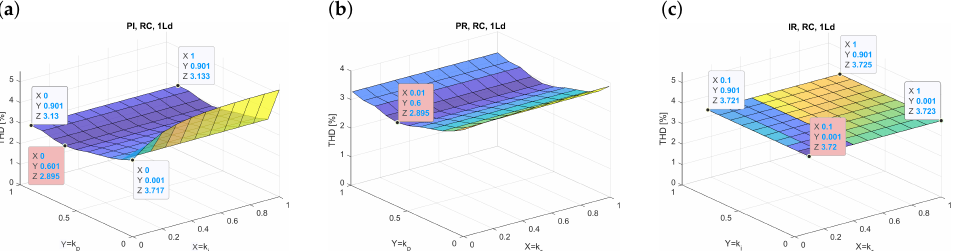
Figure 34. Surfaces of THD values as functions of controller gains for ( a ) PI, ( b ) PR, and ( c ) IR control systems. Parameters leading to the lowest THD values are marked with a reddish